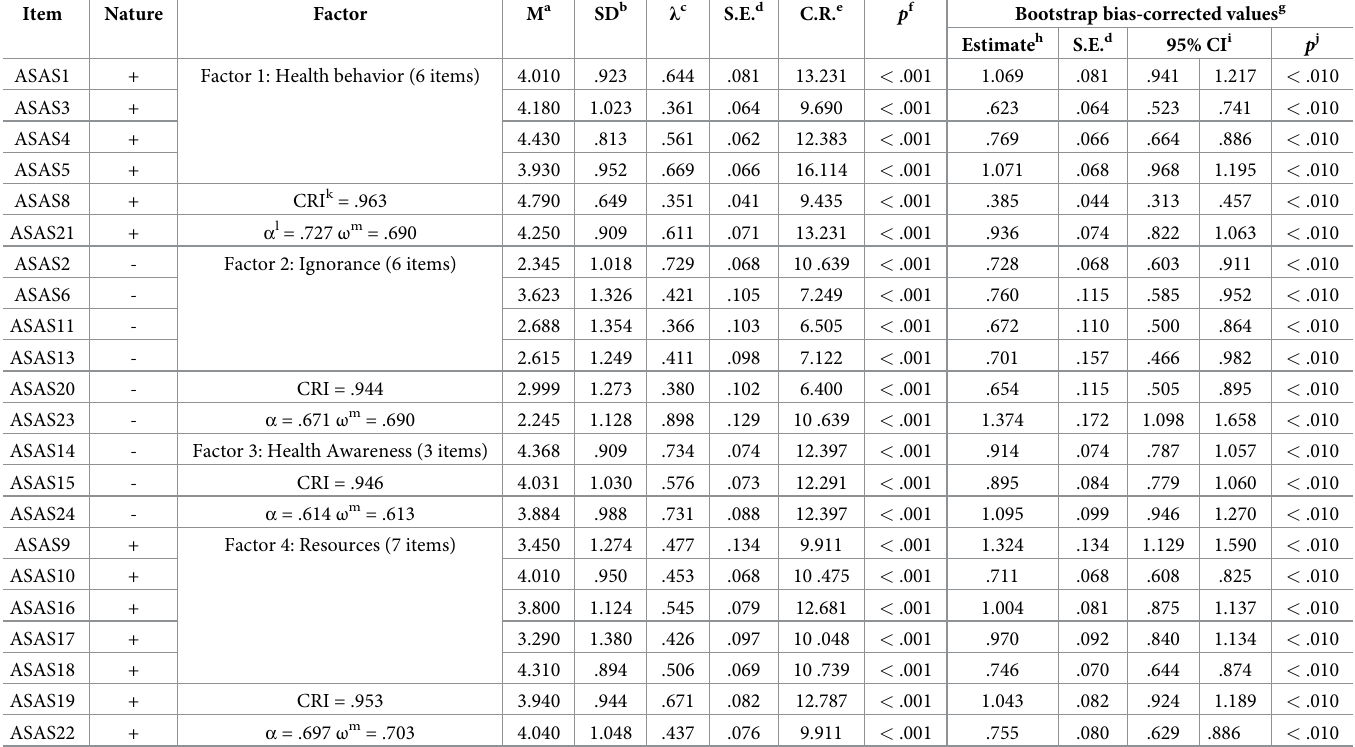
Table 4. Item descriptive—factorial composition and bootstrapped bias-corrected indices of the retained four-factor model for the